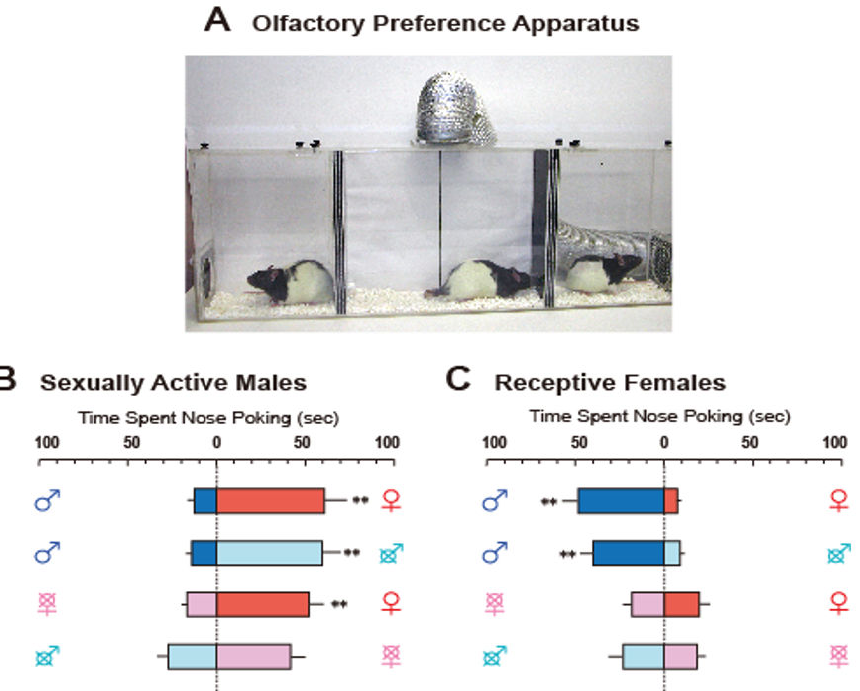
Figure 1. ( A ). The apparatus for olfactory preference test in rats, consisting of three compartments. Experimental rats were placed in the middle, and stimulus rats were placed in two neighboring side compartments. A fan connecting to the airduct at the ceiling of the middle compartment dispersed airflow from the two side compartments to convey the odors of stimulus rats. A transparent tube was placed on each air inlet in the middle compartment to facilitate observation of nose-poking. ( B ) and ( C ). Typical olfactory preference shown by sexually active male rats ( B ) and receptive female rats ( C ). Sex symbol characters on both sides of each column indicate the type of stimulus rat. Crosses over the sex symbol characters indicate gonadectomy of stimulus rat [6]. Reprinted with permission from Ref. [6]. Copyright 2004